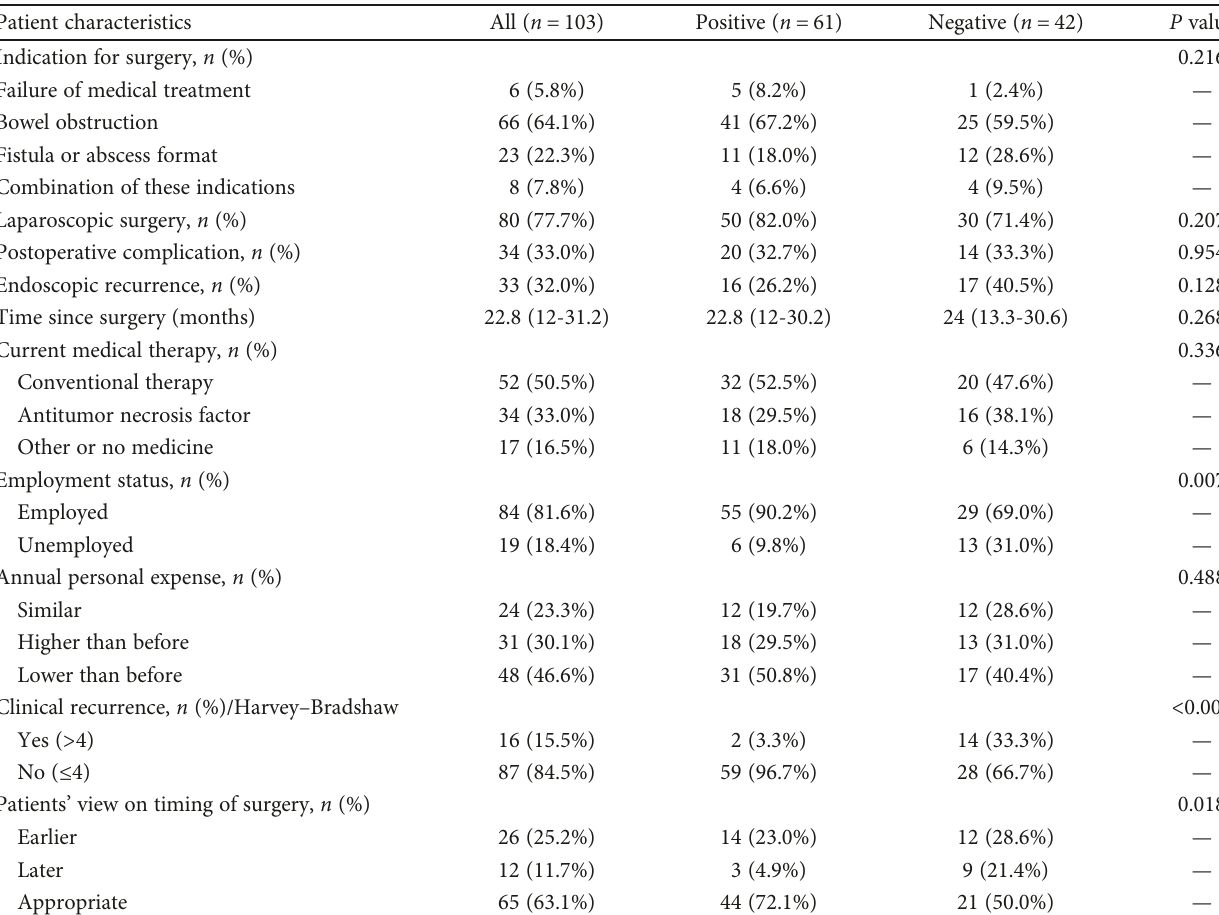
Table 2: Perioperative characteristics of the study population.